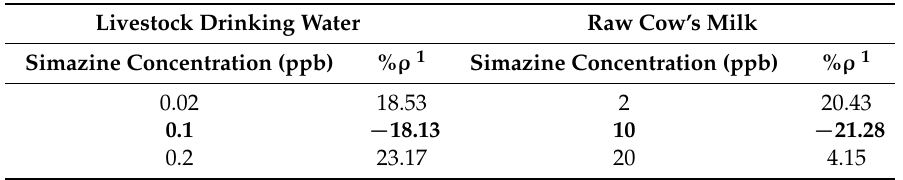
Table 2. Simazine concentrations tested (in ppb) in livestock drinking water and raw cow’s milk samples with the corresponding means values of indexes of respiratory inhibition (% ρ ). The EU legal limit for simazine residue in each matrix is indicated in bold.